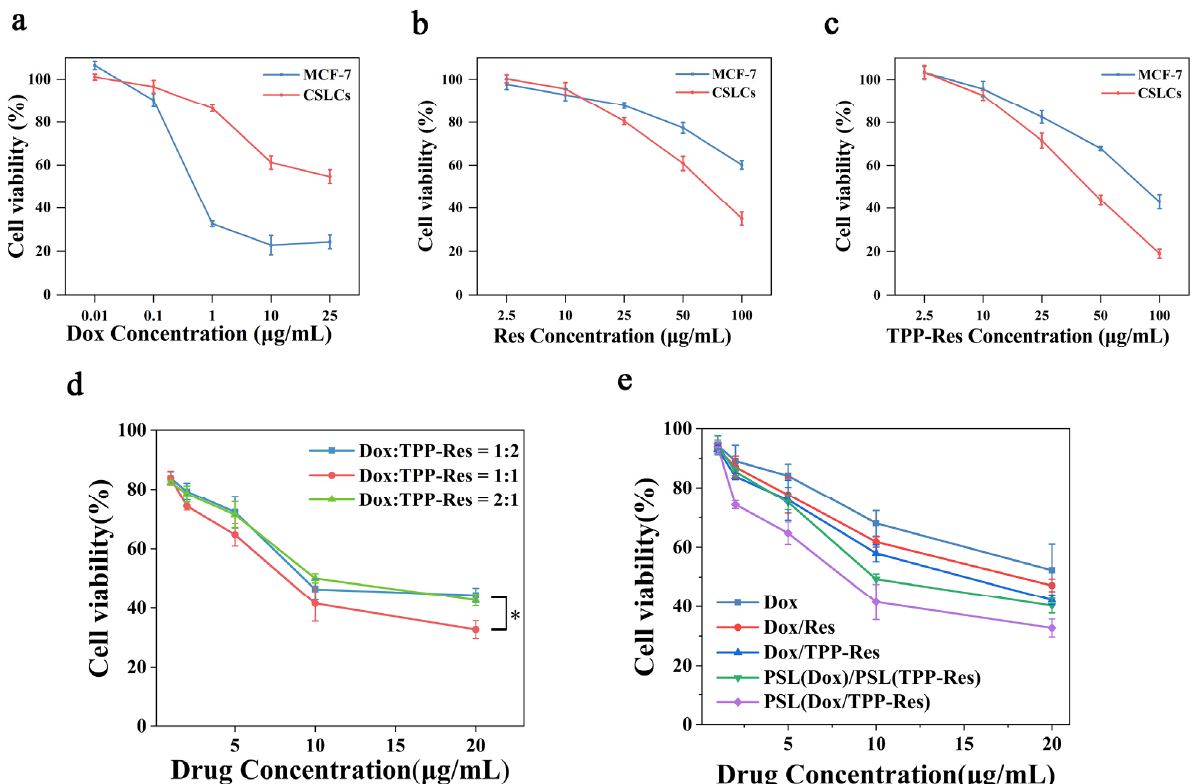
Figure 4. In vitro cytotoxicity of DOX ( a ), Res ( b ) and TPP-Res ( c ) on the MCF-7 and CSLCs; ( d ) cytotoxicity of three weight ratios (1:2, 1:1 and 2:1) of Dox and TPP-Res in the liposomes on the CSLCs. * P < 0.05 compared with the ratio of 1:1 group. ( e ) Cytotoxicity of different formulations at a Dox/TPP-Res ratio of 1:1 on the CSLCs. Cell viability (%) was expressed as a percentage compared to the untreated control cells. All data are expressed as mean values ± SD of 5 independent experiments. Table 2. The IC 50 and resistance factor (RF) on the CSLCs.